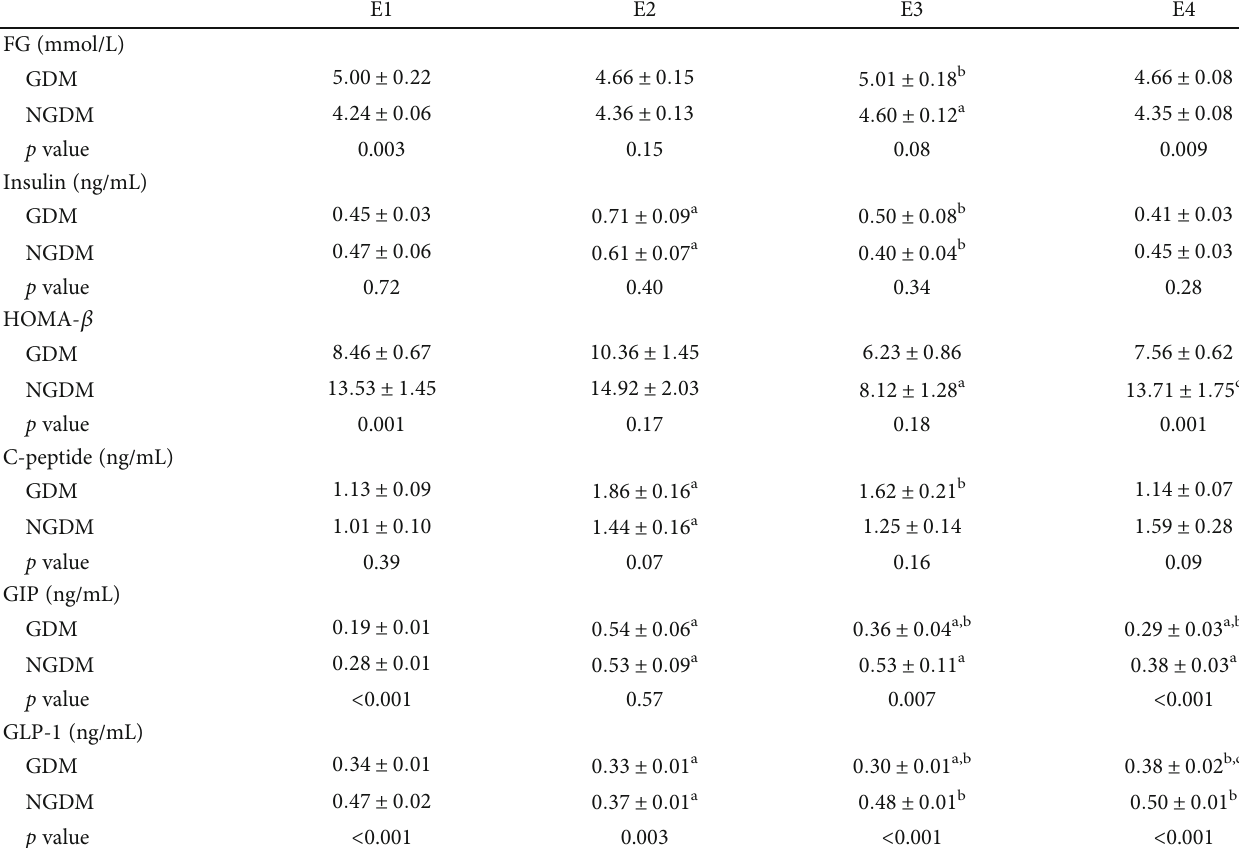
Table 2: Between- and within-group comparisons of subjects with gestational diabetes mellitus (GDM, n = 53 ) vs. control group (NGDM, n = 43 ) ( mean ± SE ). E1